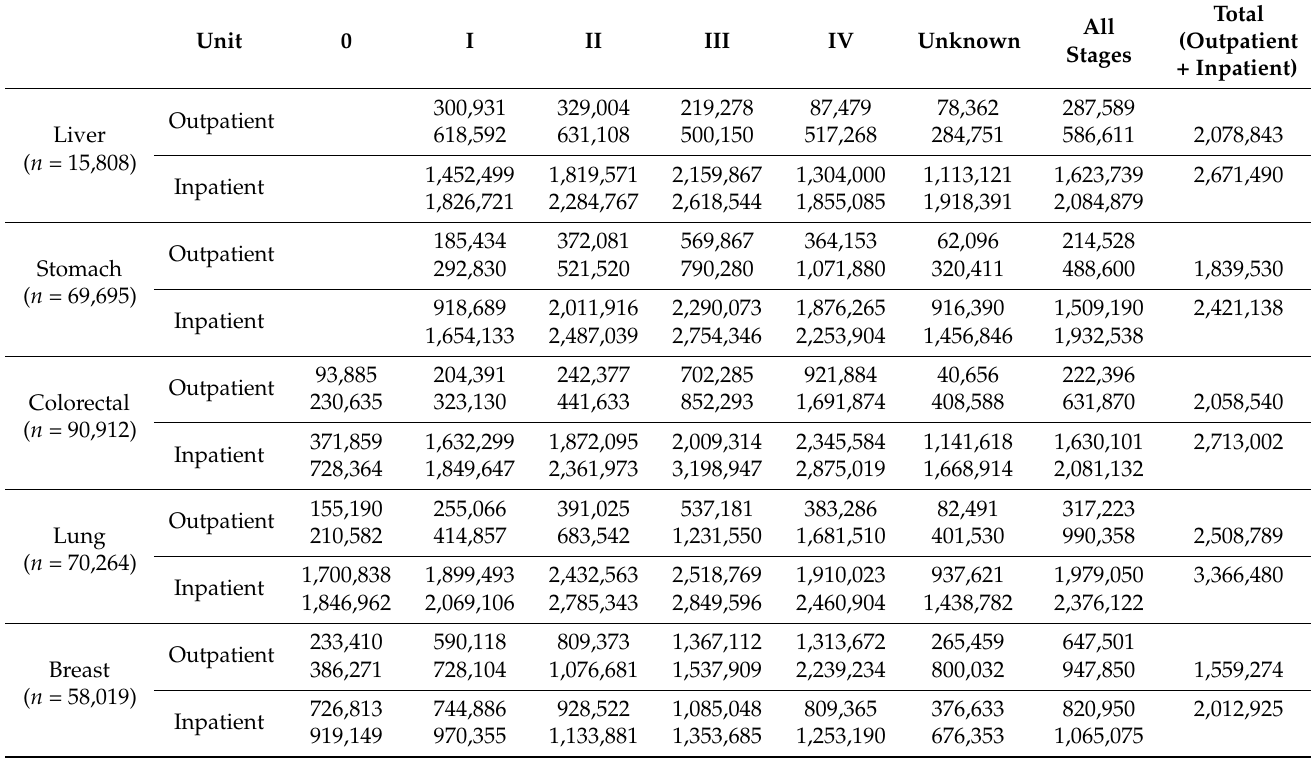
Table 2. Mean healthcare resource utilization costs of the five major cancers within a year after diagnosis per-patient in Japan (upper row: median, lower row: mean, unit: Yen).